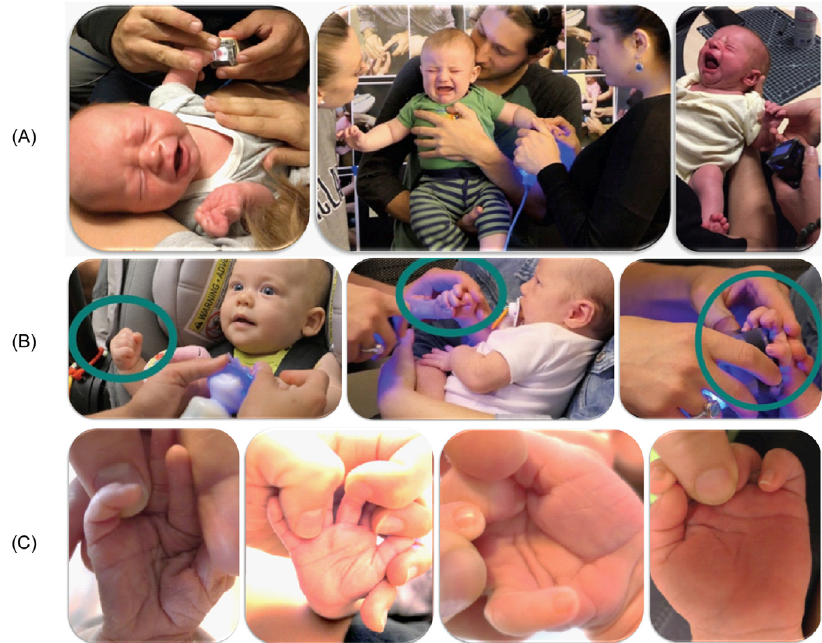
Figure 1. Interaction design must account for infant reflexes and behaviors. Written informed consent was obtained from parents/ guardians for the publication of all